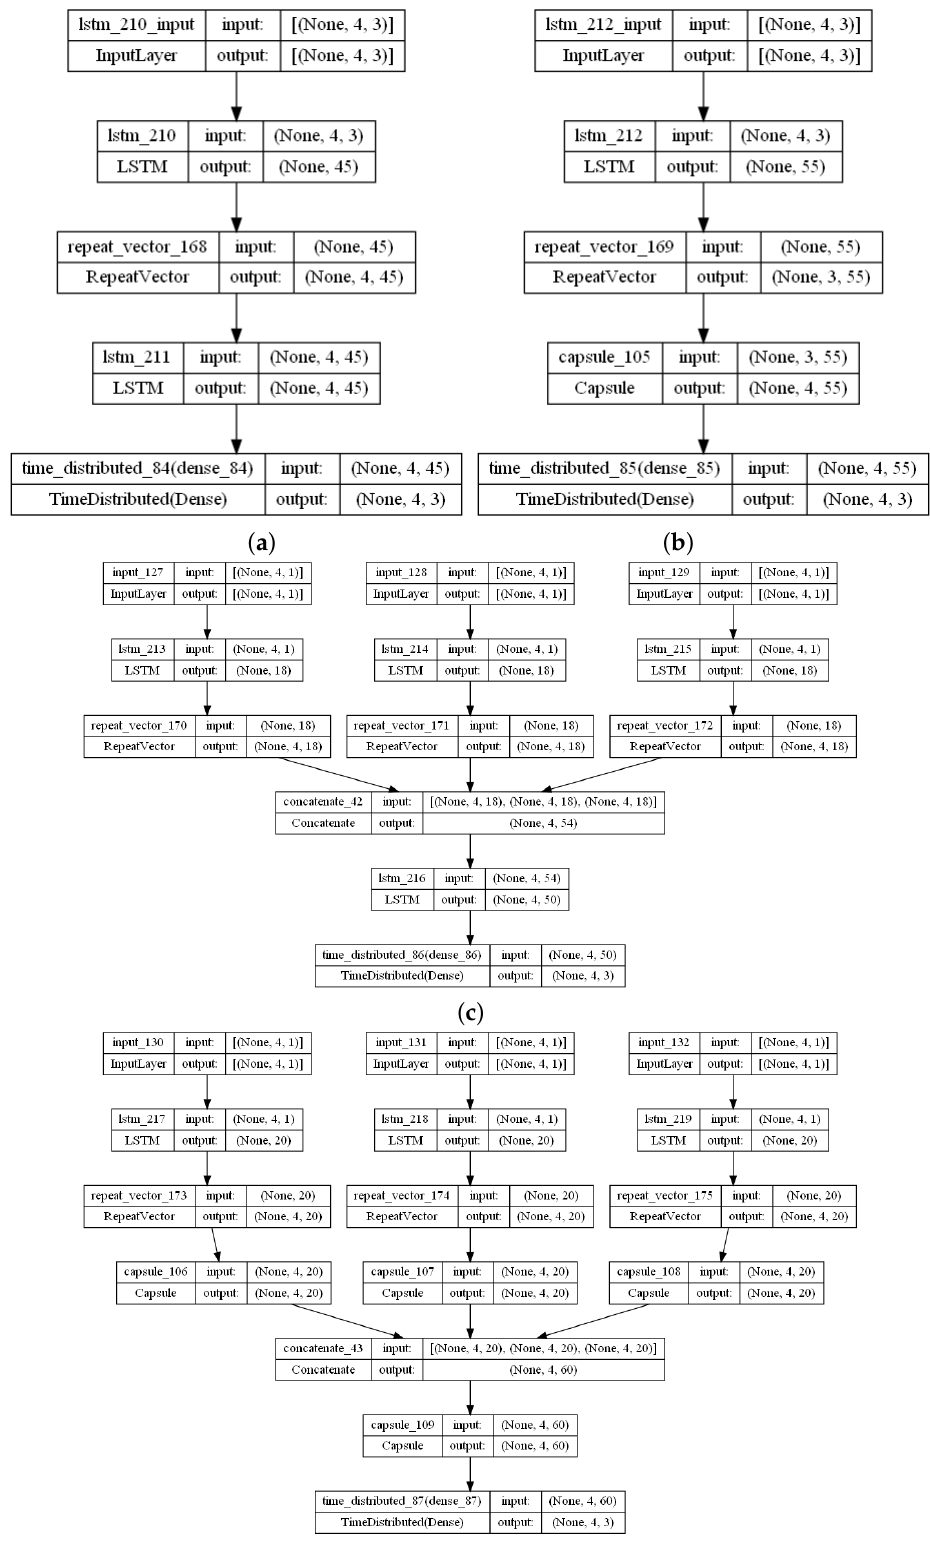
Figure 5. Visualisation of models used for experimentation. ( a ) Design A: single channel LSTM; ( b ) Design B: single channel LSTMCaps; ( c ) Design C: multi-channel LSTM; ( d ) Design D: multi- channel LSTMCaps (the proposed